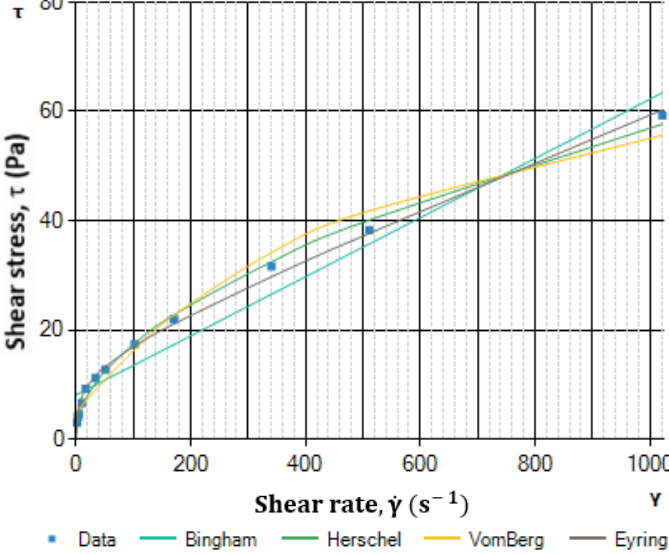
Figure 4. Comparison of the selected rheological models, cement w/c 0.46.